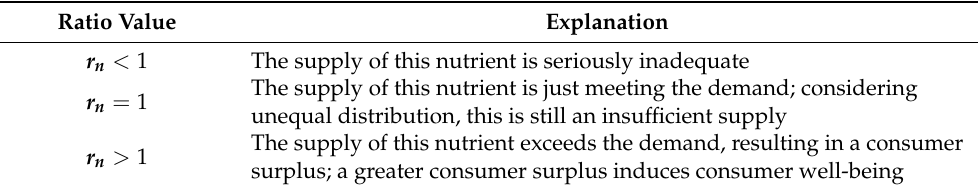
Table 1. The explanation of supply